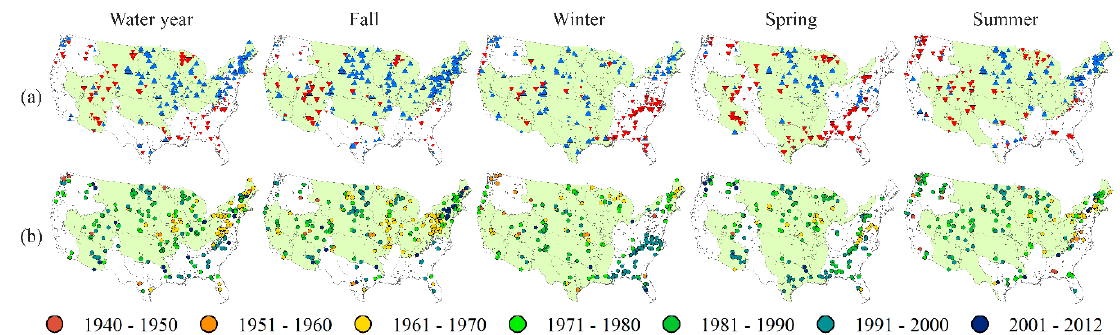
Figure 3. Spatial distribution of the persistence in water year and the four seasons.